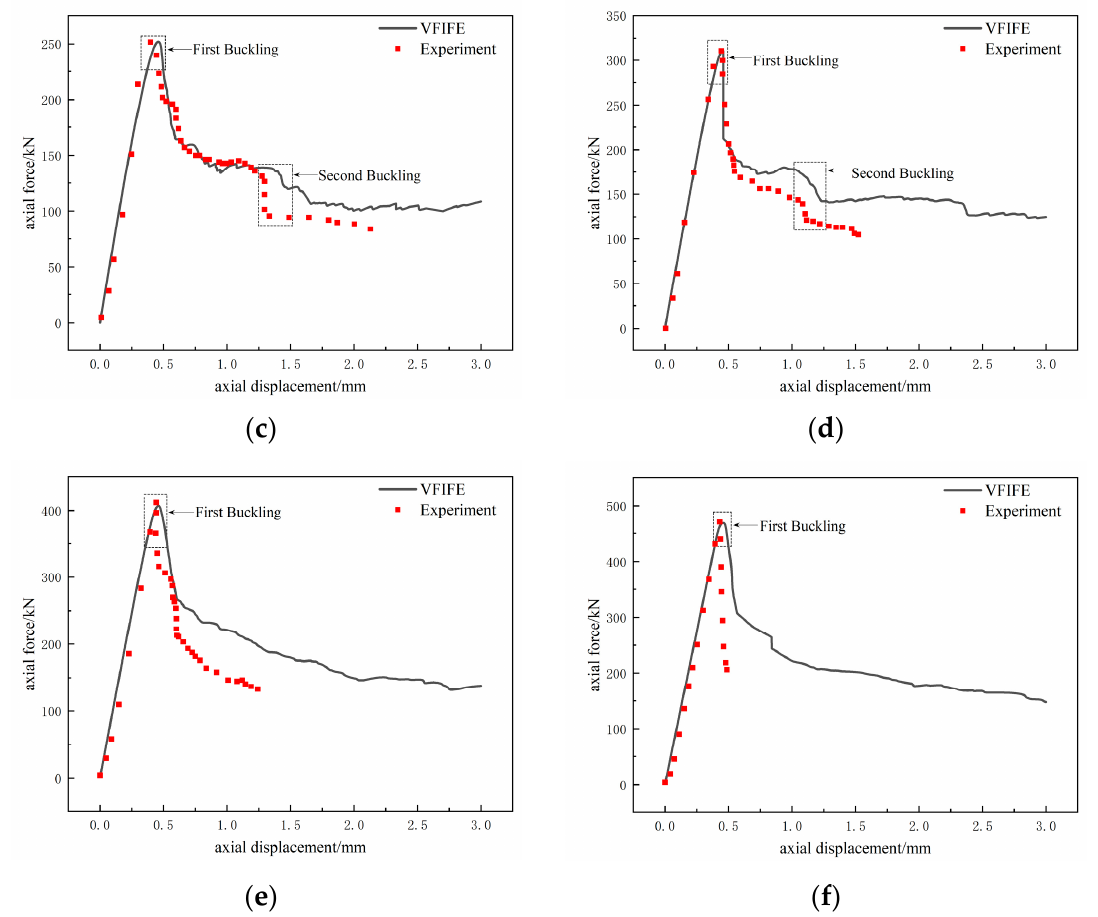
Figure 8. Axial displacement-force curve: ( a ) 2 × 30°, ( b ) 2 × 60°, ( c ) 2 × 90°, ( d ) 2 × 120°, ( e ) 2 × 150°, ( f ) 2 × 180°.